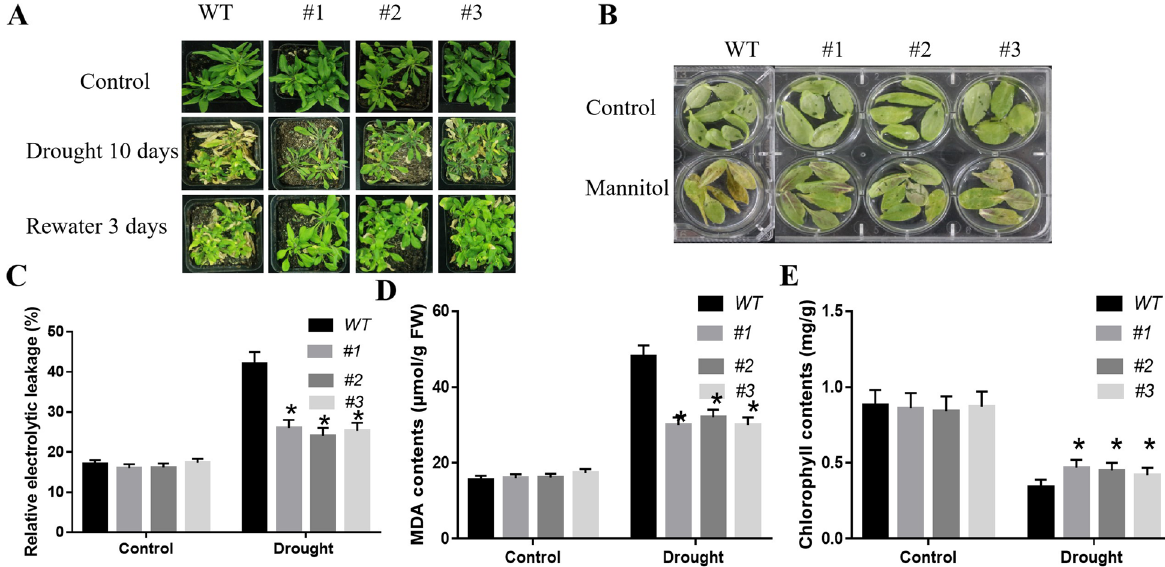
Fig. 4 Overexpression of CaSLP confers enhanced drought tolerance to transgenic Arabidopsis. A - B The phenotype of transgenic and wild-type (WT) plants before and after 10 d of drought treatment. Plants were treated under water deficit conditions for 10 d, then rewatered for 3 d. C - E Relative electrolyte leakage ( C ), and Malondialdehyde (MDA) content ( D ), Chlorophyll content ( E ) of the transgenic and WT plants before and after the drought treatment. Values are means SD ( n 3). Asterisks show a significant difference between the transgenic lines and WT under drought ± = stress (*, P < 0.05; **, P <